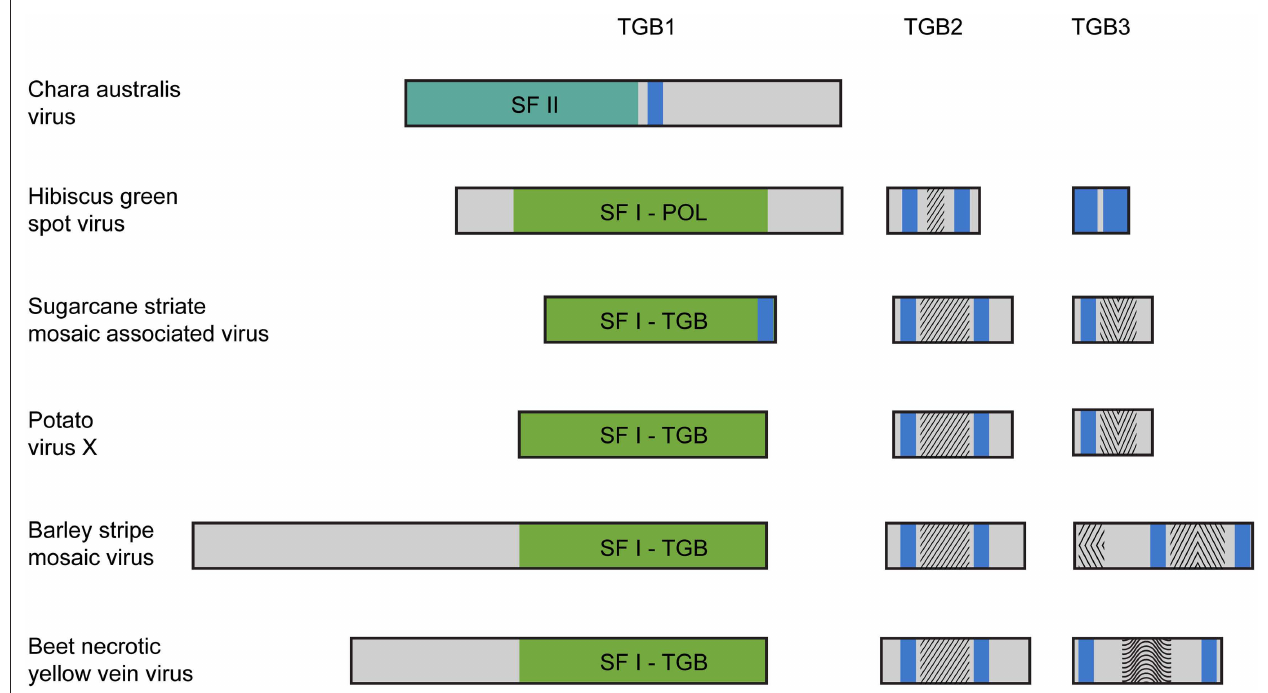
Figure 1 | Organization of triple gene block (TgB)-encoded proteins of some plant viruses. Boxes schematically represent open reading frames. It should be noted that in fact the TGB2 coding sequence overlaps the 3 ′ end of TGB1 gene, and the TGB3 ORF overlaps the 3 ′ end of TGB2 gene (Morozov and Solovyev, 2003). Helicase domains are indicated in the green boxes (SF-I) and dark green box (SF-II). Blue boxes represent the hydrophobic segments found in TGB proteins. Conserved sequence signatures in hydrophilic segments of TGB2 and TGB3 proteins are indicated by different shading within the boxes. In all studied TGBs, the TGB2 proteins have a highly conserved signature in the central part of their sequence. Note that the Hibiscus green spot virus TGB2 protein includes a shortened version of the TGB2 conserved signature. The TGB3 proteins are diverse in different virus groups. In Potato